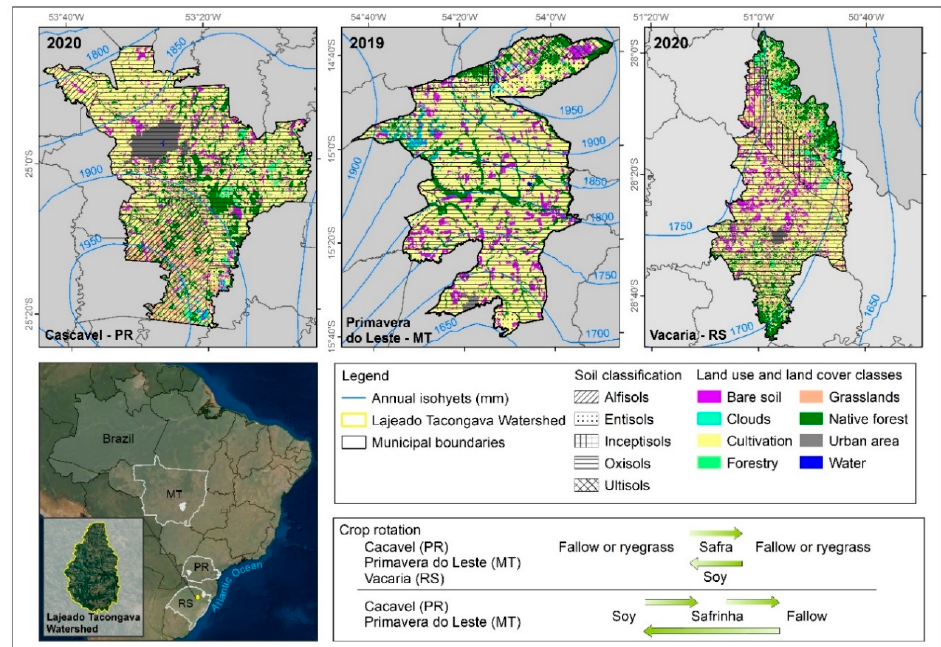
Figure 3. Location of production regions analyzed, land use and land cover map, annual mean precipitation (mm), and crop rotation scheme. Land use and land cover map of Primavera do Leste (MT) was drawn up considering the satellite image of 2019 due to its better quality, with fewer clouds, in comparison to the image available for